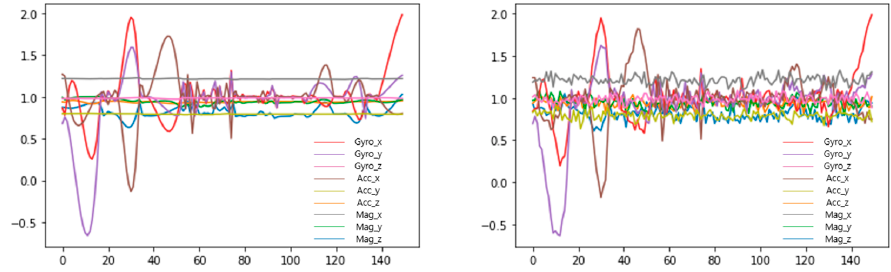
Figure 10. Behavioral data (walking) augmented graph (( Left ): original, ( Right ): augmented). Table 5. Con fi guration before and after experimental dataset augmentation.